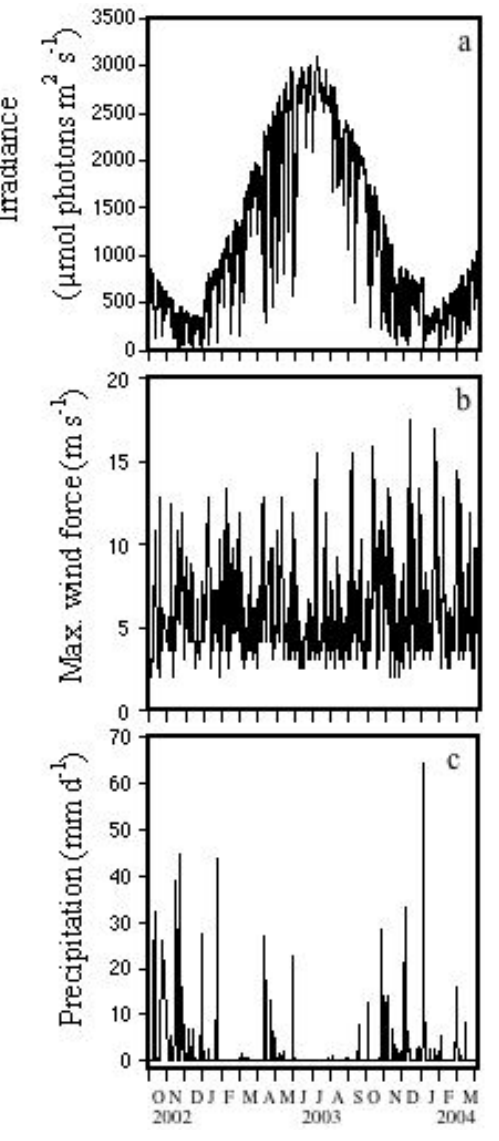
Fig. 1. Meteorological parameters during the study period. Data were collected on a daily basis. (a) Irradiance, (b) wind intensity and (c) precipitation.